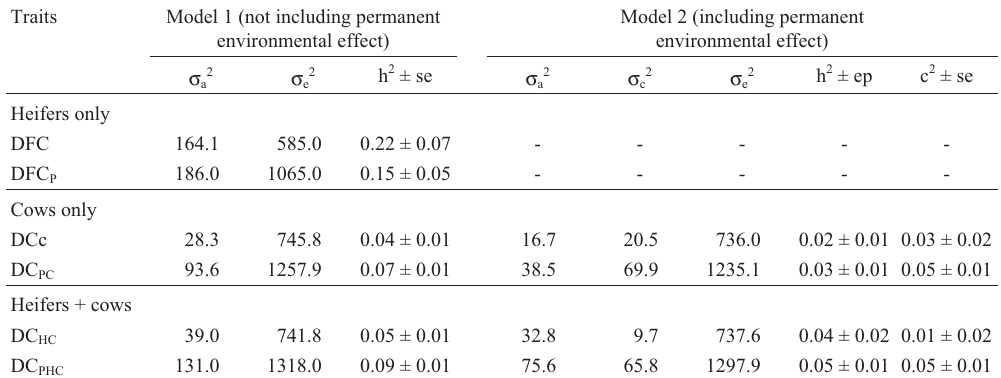
Table 2 - Variance components and genetic parameter estimates obtained in one-trait analyses of a Canchim herd. Table shows the following traits: days to first calving without (DFC) and with (DFC P ) penalization of non-calving heifers; days to calving without (DC) and with (DC P ) penalization of non-calving cows. Additive genetic variance ( σ a2 ); permanent environmental variance ( σ c2 ); residual variance ( σ e2 ); heritability (h 2 ); fraction of the vari- ance due to permanent environment (c 2 ); and standard error (se). The subscript C (DC C and DC PC ) stands for cows only and HC (DC HC and DC PHC ) for heifers and cows